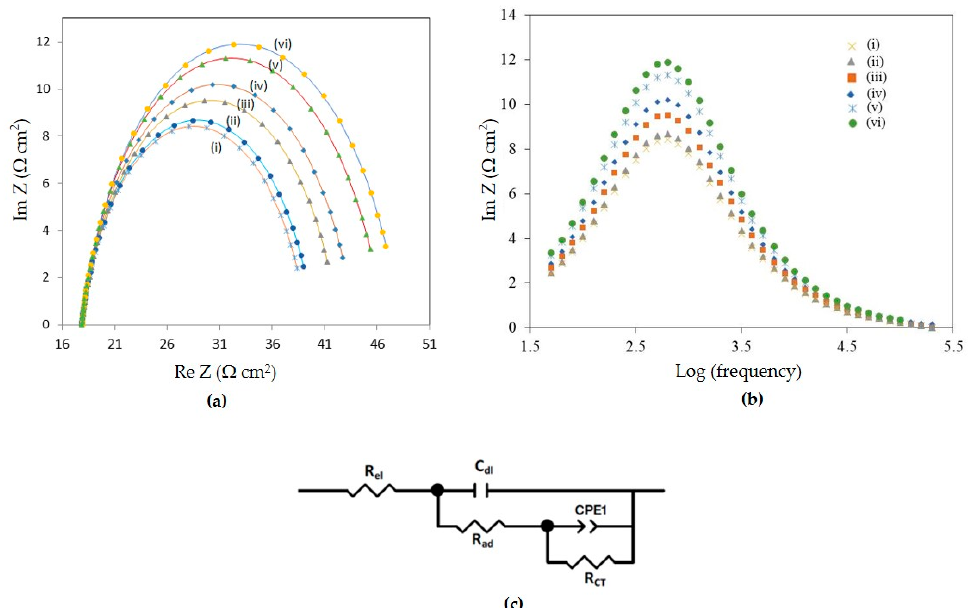
Figure 6. ( a ) Nyquist and ( b ) Bode plots showing measured data (individual data points) and modelled data (solid lines) using the equivalent circuit depicted in ( c ): (i) CaMn 2 O 4 nanowires / PPy (with light illumination),(ii) CaMn 2 O 4 nanowires / PPy (without light illumination), (iii) irregular-shaped CaMn 2 O 4 particles / PPy (with light illumination), (iv) irregular-shaped CaMn 2 O 4 particles / PPy (without light illumination) (dark), (v) PPy only (with light illumination) and (vi) PPy only (without light illumination). ( Figure 6 (c) is reprinted with permission from ref. [17]. Copyright (2018)